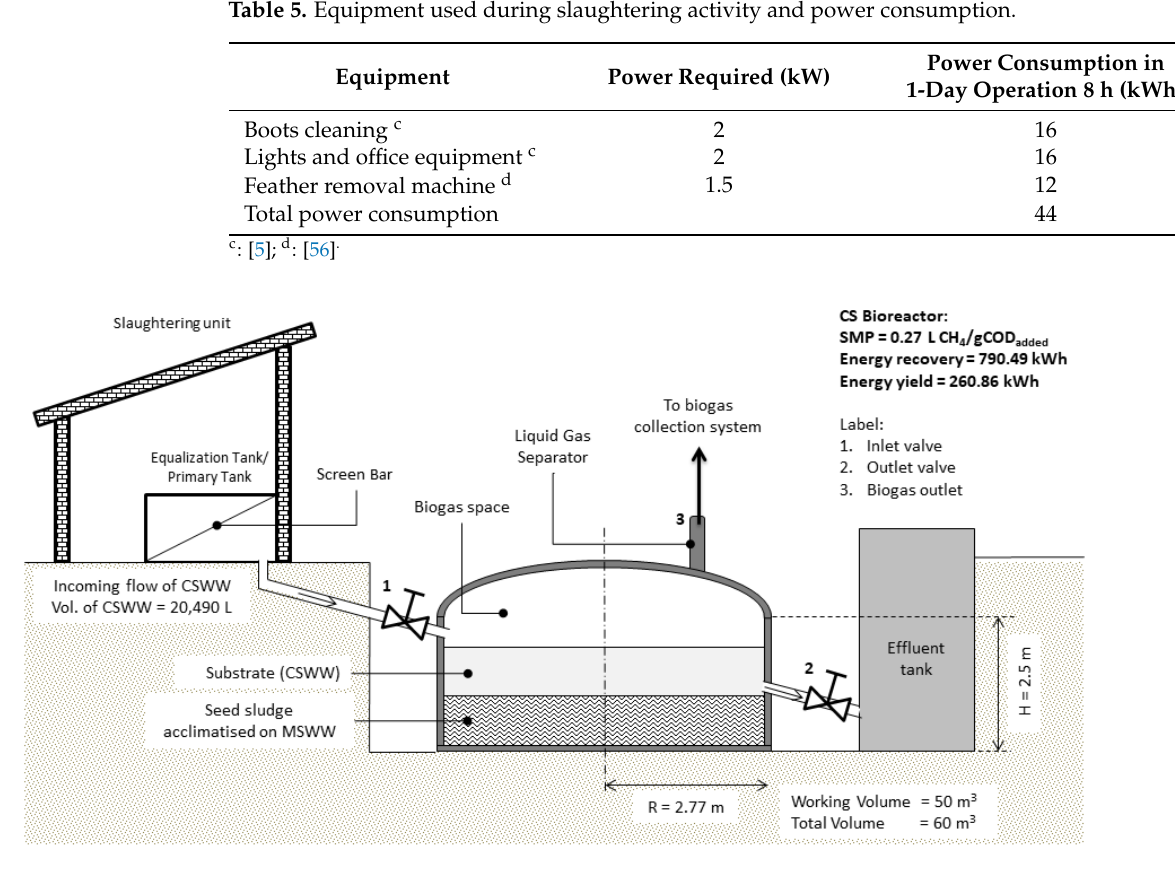
Figure 13. Process flow diagram of on-site CS CSWW treatment.